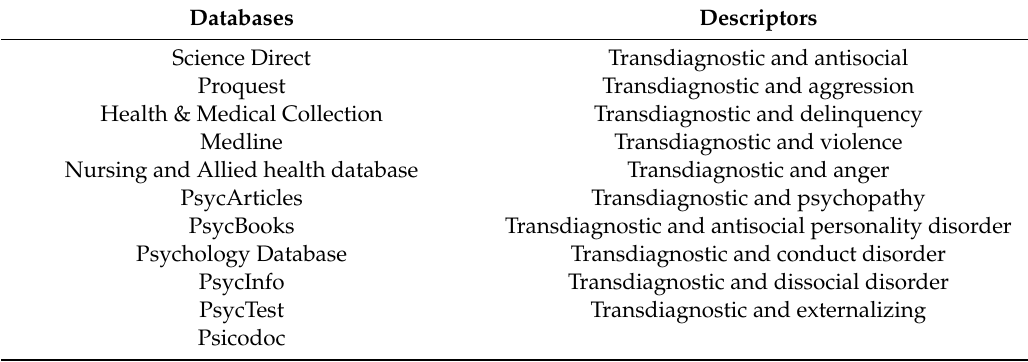
Table 1. Reviewed and descriptors Used in the Meta-searchers